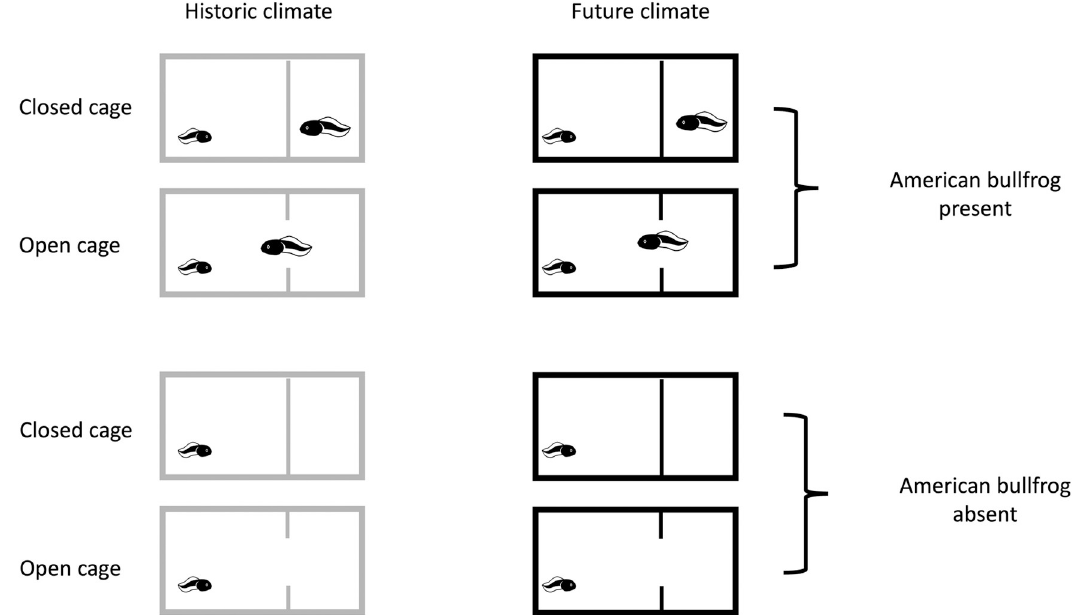
Fig 1. Representation of eight treatment groups in the experimental design. The smaller tadpole represents a single Pacific chorus frog ( Pseudacris regilla ) larva, while the larger tadpole represents a single American bullfrog ( Lithobates catesbeianus ) larva. Dividing lines within the tanks represent the cage treatment (open or closed). Tadpole images are from artist Parkjisun, sourced from The Noun Project website, under a Creative Commons-BY